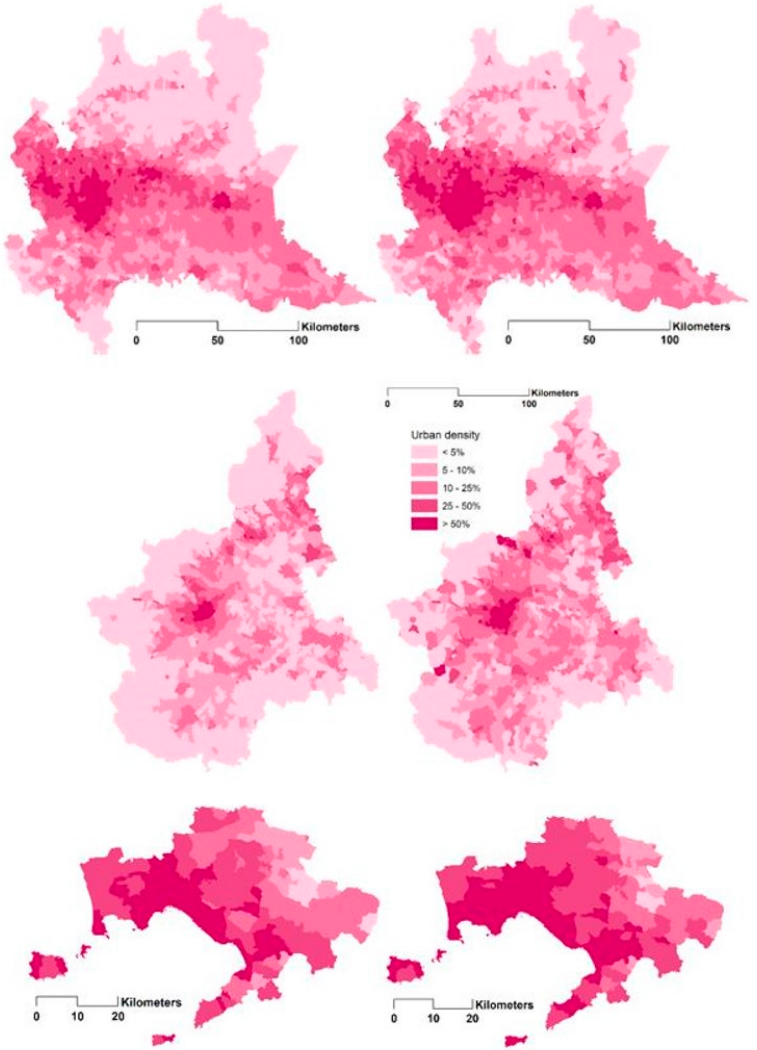
Figure 8. Variations in urbanisation density deriving from the complete implementation of the contents of the municipal regulatory plans in three sample cases (from high to low) of Lombardy, Piedmont, and the Metropolitan City of Naples.